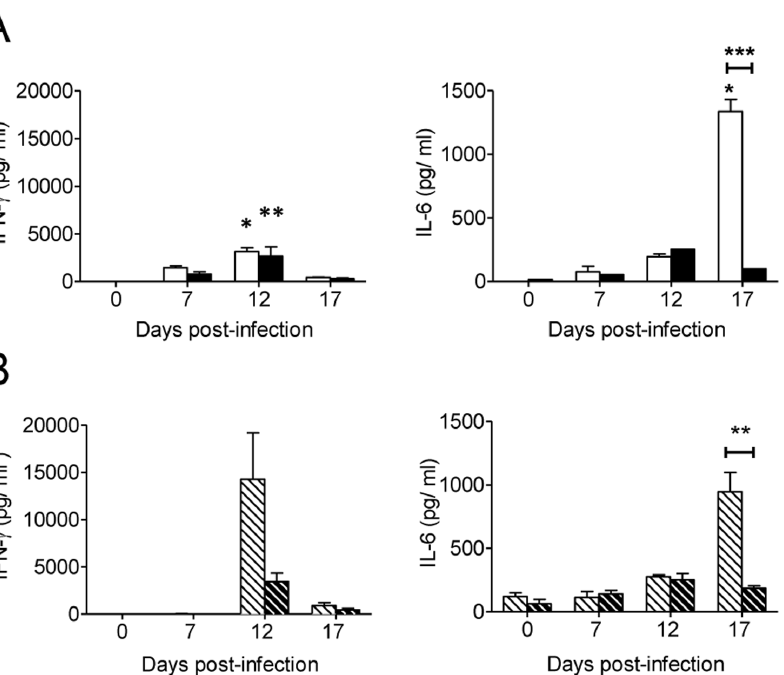
Figure 5. IL-6 serum concentration significantly increased in infected BALB/c mice. BALB/c mice were infected with high inoculum (open bar) or low inoculum (open dashed bar). C57BL/6 mice were infected with high inoculum (filled bar) or low inoculum (filled dashed bar). IFN- c and IL- 6 concentrations were determined from sera extracted from non-infected (NI) mice and mice infected with ( A ) high inoculum or ( B ) low inoculum at 0 (NI), 7, 12 and 17 d.p.i. Data represent the results of at least two independent experiments performed with 3 mice per experimental group. Statistically significant differences between infected and non-infected mice (0 d.p.i.) and between BALB/c and C57BL/6 mice under each treatment are shown: * p , 0.05,** p , 0.01 and *** p ,